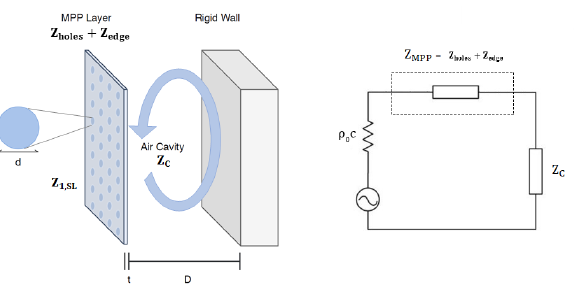
Figure 2. Single-layer (SL)-MPP schematic representation ( left ) and the corresponding equivalent electrical system ( right ).